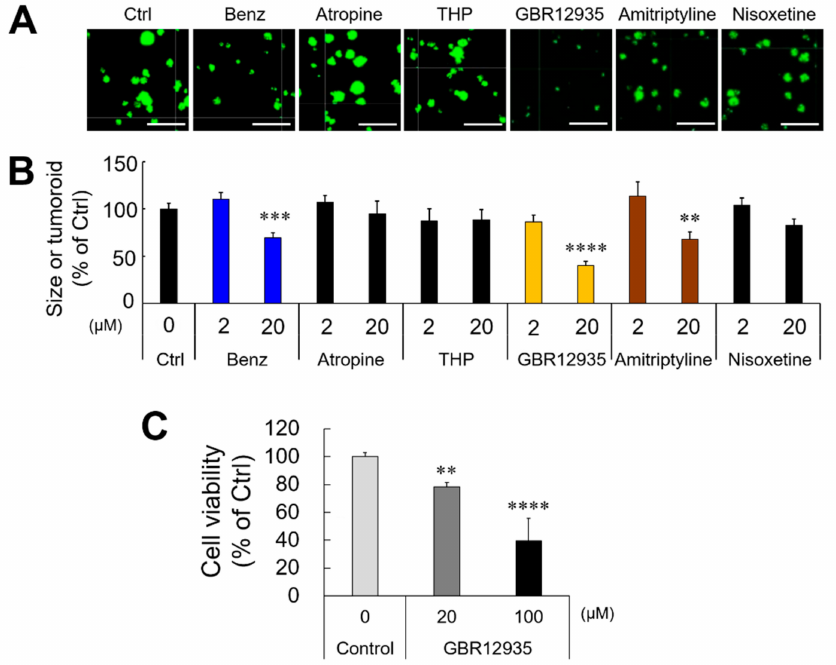
Figure 5. Anti-tumor e ff ect of Benztropine through the inhibition of the dopamine transporter